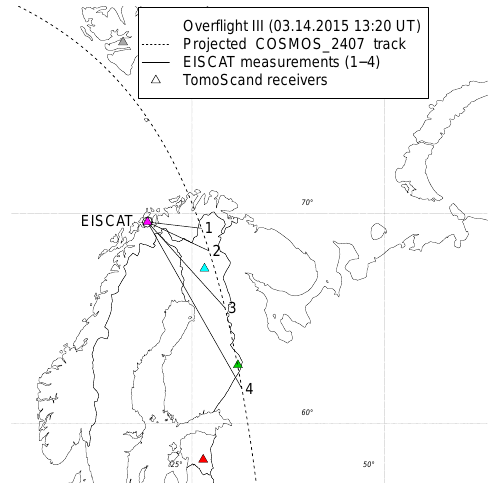
Figure 5. TomoScand receiver network and the satellite overflight ground track with four EISCAT UHF scan paths.